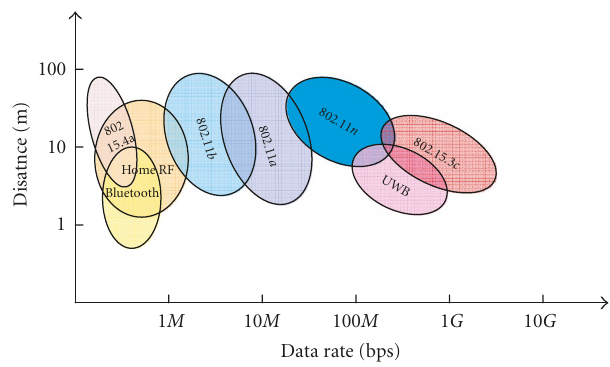
Figure 1: Data rates and range requirements for WLAN and WPAN standards and applications. Millimeter wave technology, that is, IEEE 802.15.3c is aiming for very high data